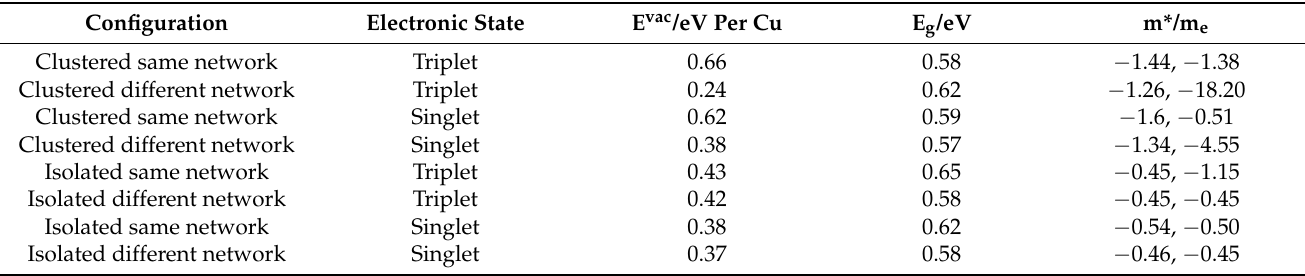
Table 3. Cu vacancy formation energy and effective hole masses for configuration with 2 Cu vacancies. Data from [90], with the permission of Elsevier.